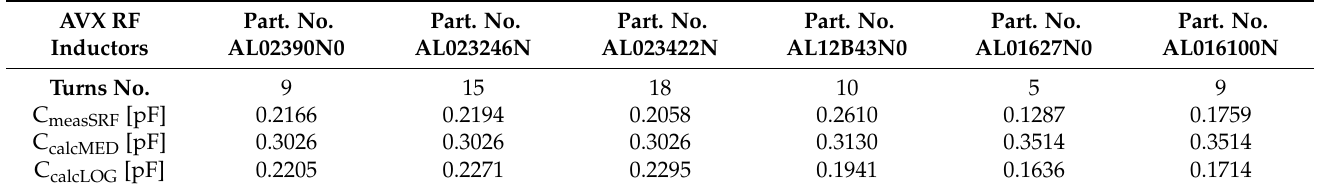
Table 1. RF inductors measured self-capacitance compared to the calculated Medhurst and our log- arithmic formulas.